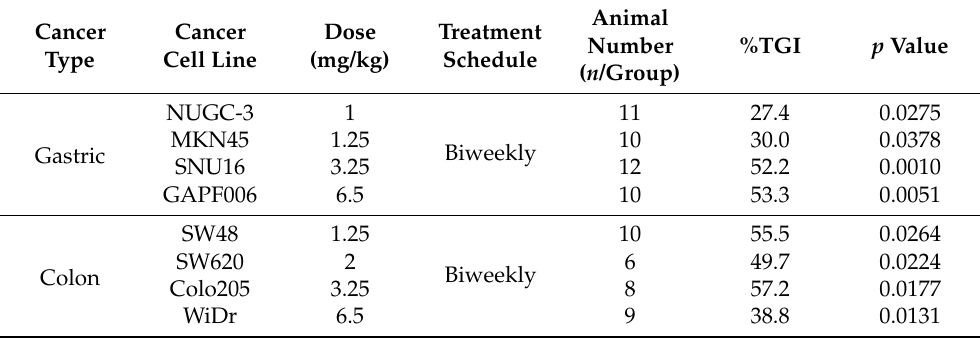
Table 1. Summarized information of animal studies using human gastric and colon cancer xenograft